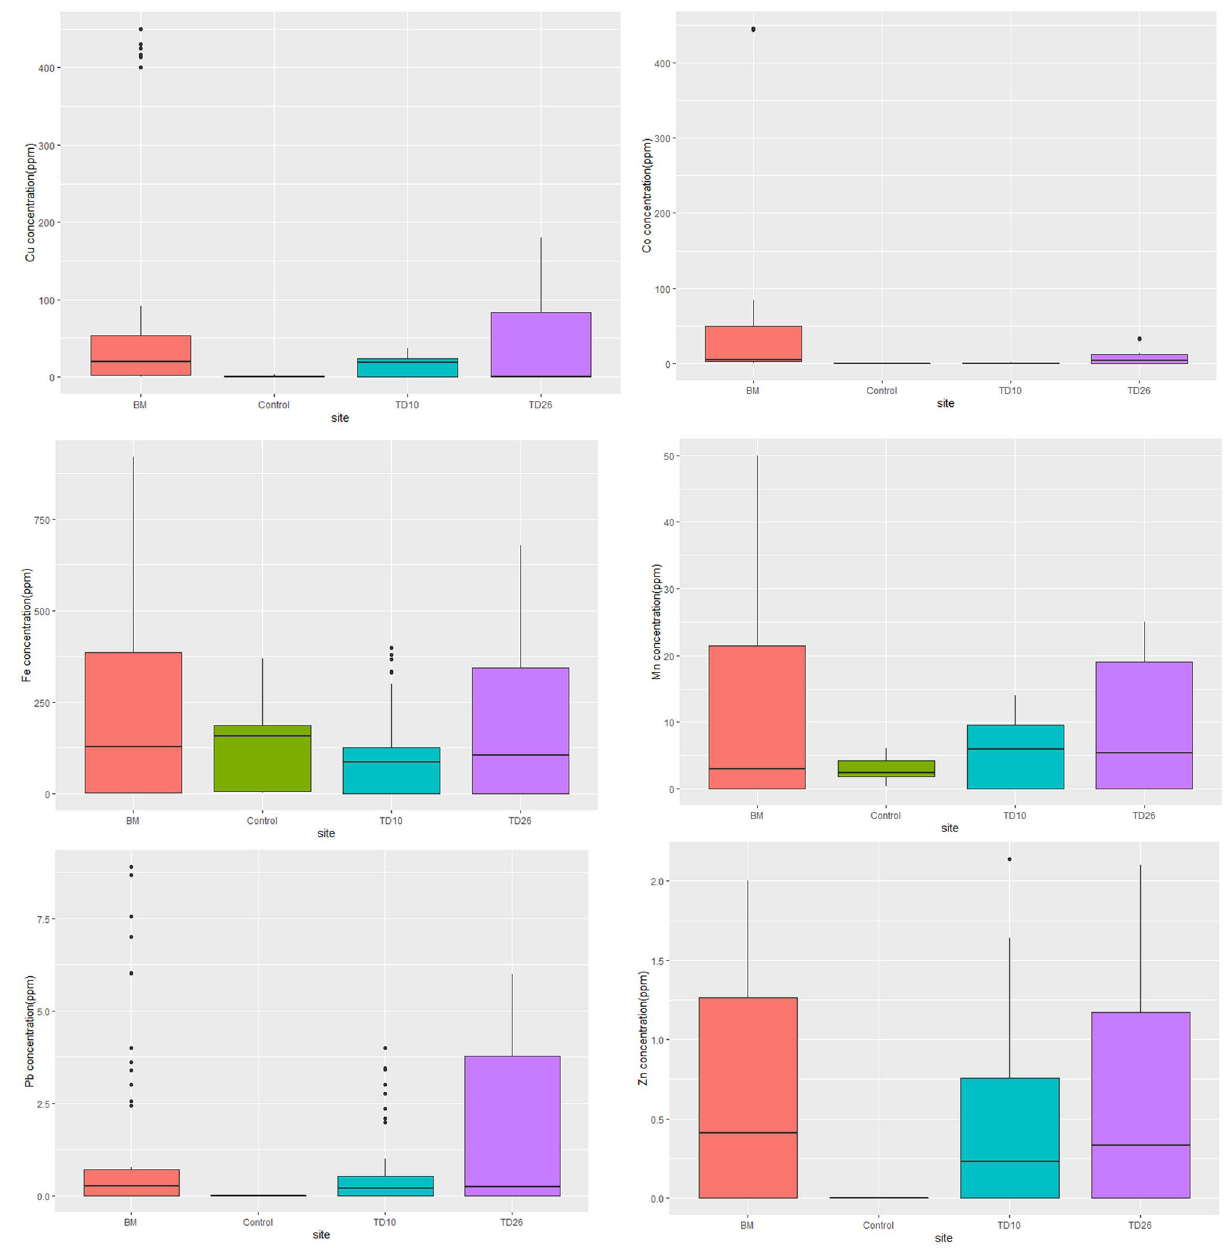
Figure 5. Boxplot of the heavy metal concentrations in soil samples of the three sampling sites, namely: BM, TD26, and TD10. The black solid line inside the box is the median value, and the black rhombus is the mean value; the black dots are individual